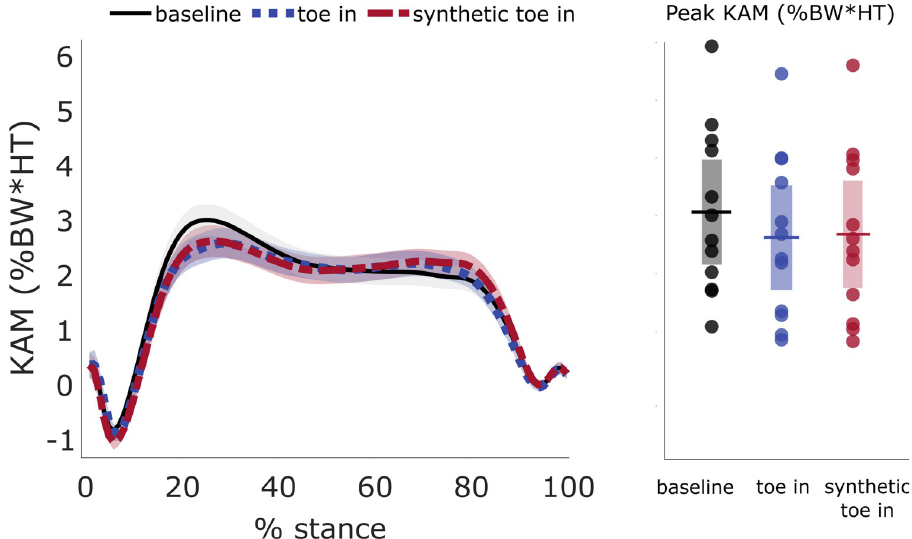
Fig 4. Validation of toe-in KAM trajectories and first peak KAM reductions (Stanford University dataset). With leave-one-out cross-validation, the synthetic toe-in KAM trajectory (red, dashed line) from the Stanford University dataset closely matched the ground-truth toe-in KAM (blue, dotted line). Synthetic KAM captured the within-subject reduction in the first peak of KAM relative to baseline (black, solid line) with an MAE of 0.174%BW � HT. The left plot captures mean ( ± STD) KAM trajectories across subjects, while the right plot shows individual and mean peak KAM with 95% confidence intervals.